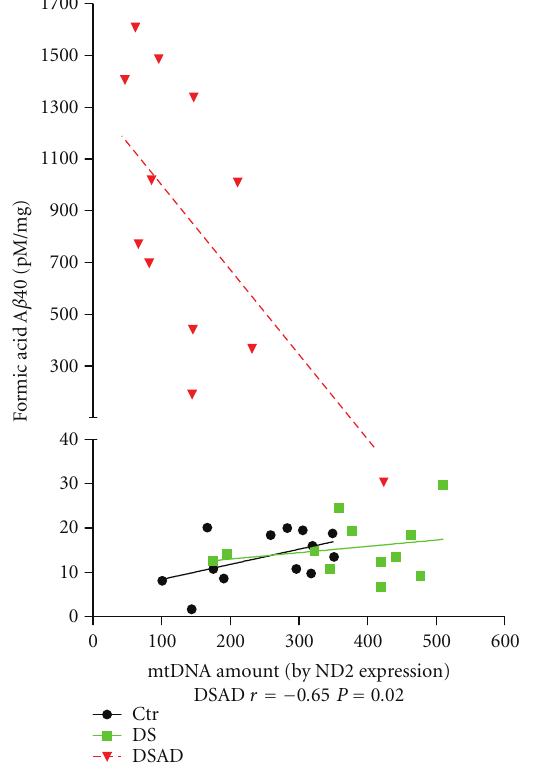
Figure 2: Levels of A β correlated with mitochondrial biogenesis represented as mtDNA amount. There was a significant inverse correlation between insoluble A β and mitochondrial DNA amount only in DSAD cases. Results reprinted from